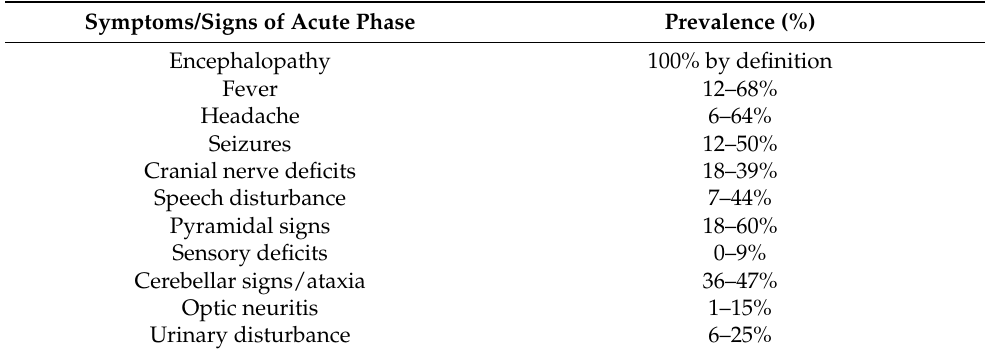
Table 2. Prevalence of clinical features in pediatric acute disseminated encephalomyelitis (ADEM). Symptoms/Signs of Acute